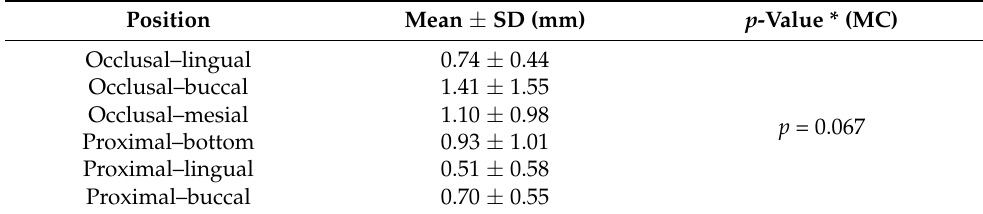
Table 2. Statistical results of marginal discrepancy of sample 7Z3N (N =